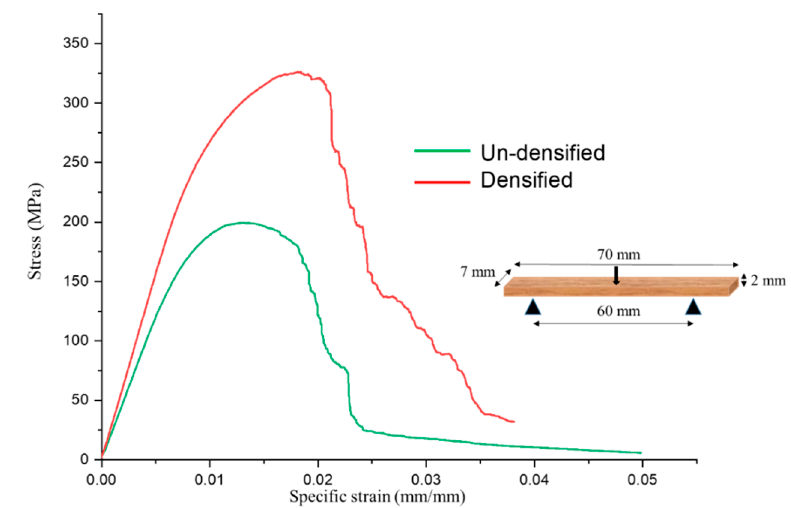
Figure 17. Stress-strain bending plot of non-densified and densified samples with 10% of moisture content (data from [65]).